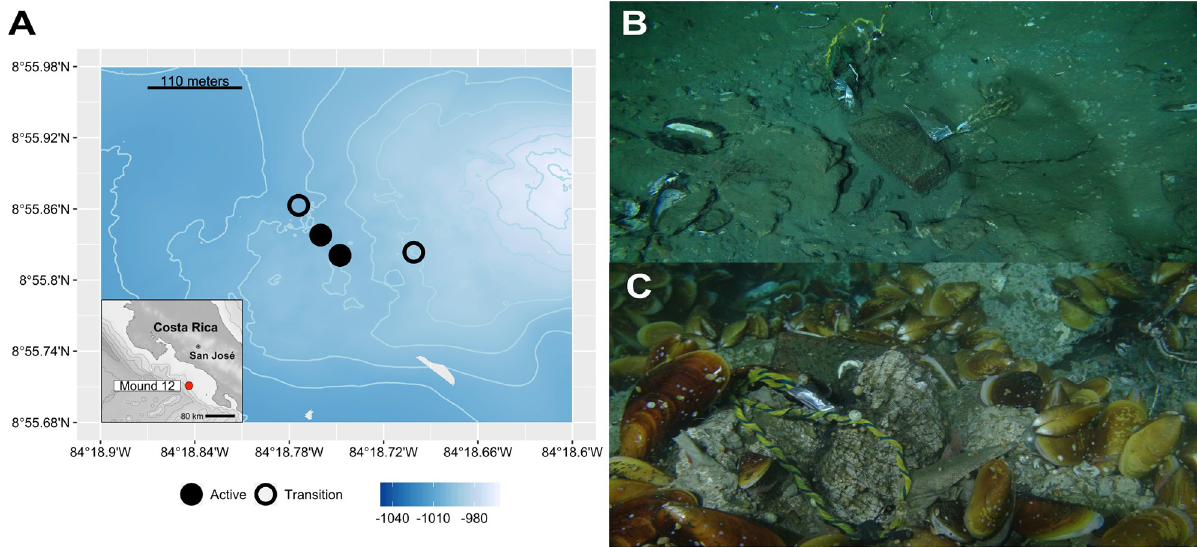
Fig 1. Sampling locations of the experimental substrates and photos in situ . Experimental bones, wood, and carbonate rocks were deployed for 7.4 years (2010–2017) at (B) active and (C) transition sites at Mound 12. The map was plotted in R Software using marmap 1.0.6 package ‘getNOAA.bathy ()’ function, which queries the ETOPO1 database hosted on the NOAA website in the public